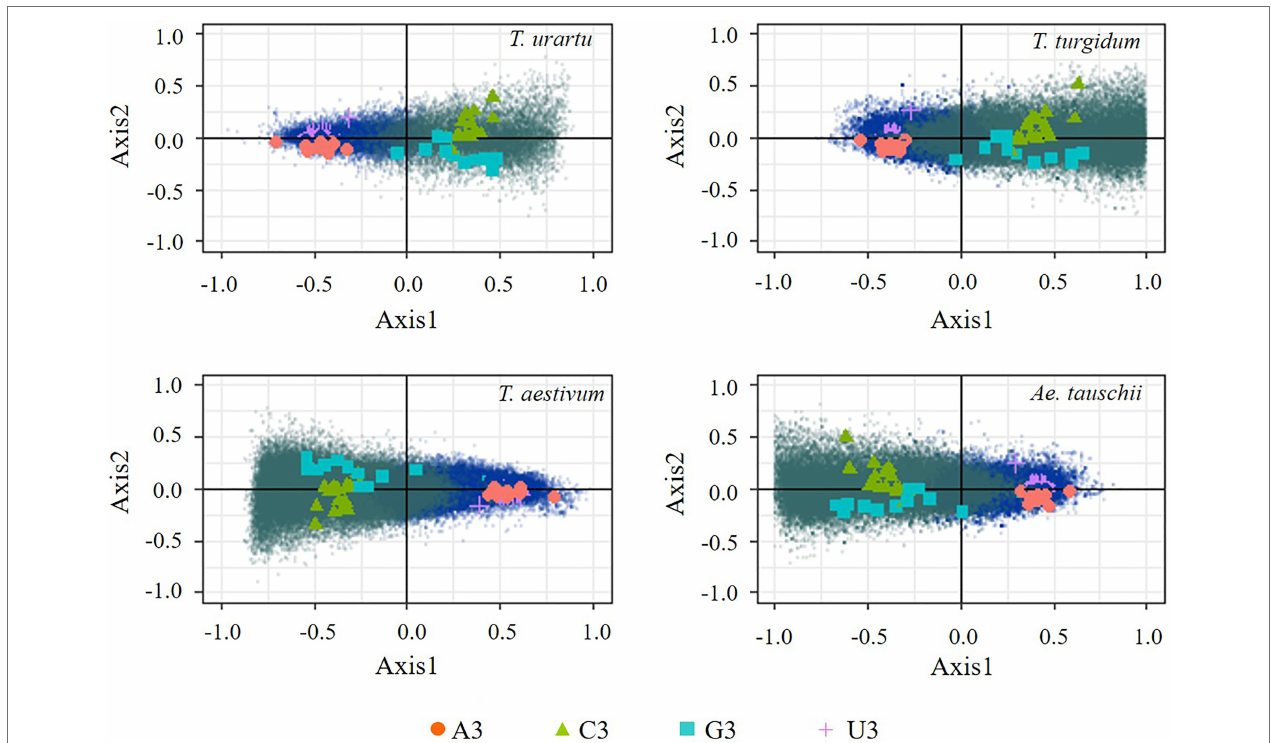
Gene Ontogeny Enrichment of GC/AT Biased Genes Based on GO categories, the functional enrichment of codon